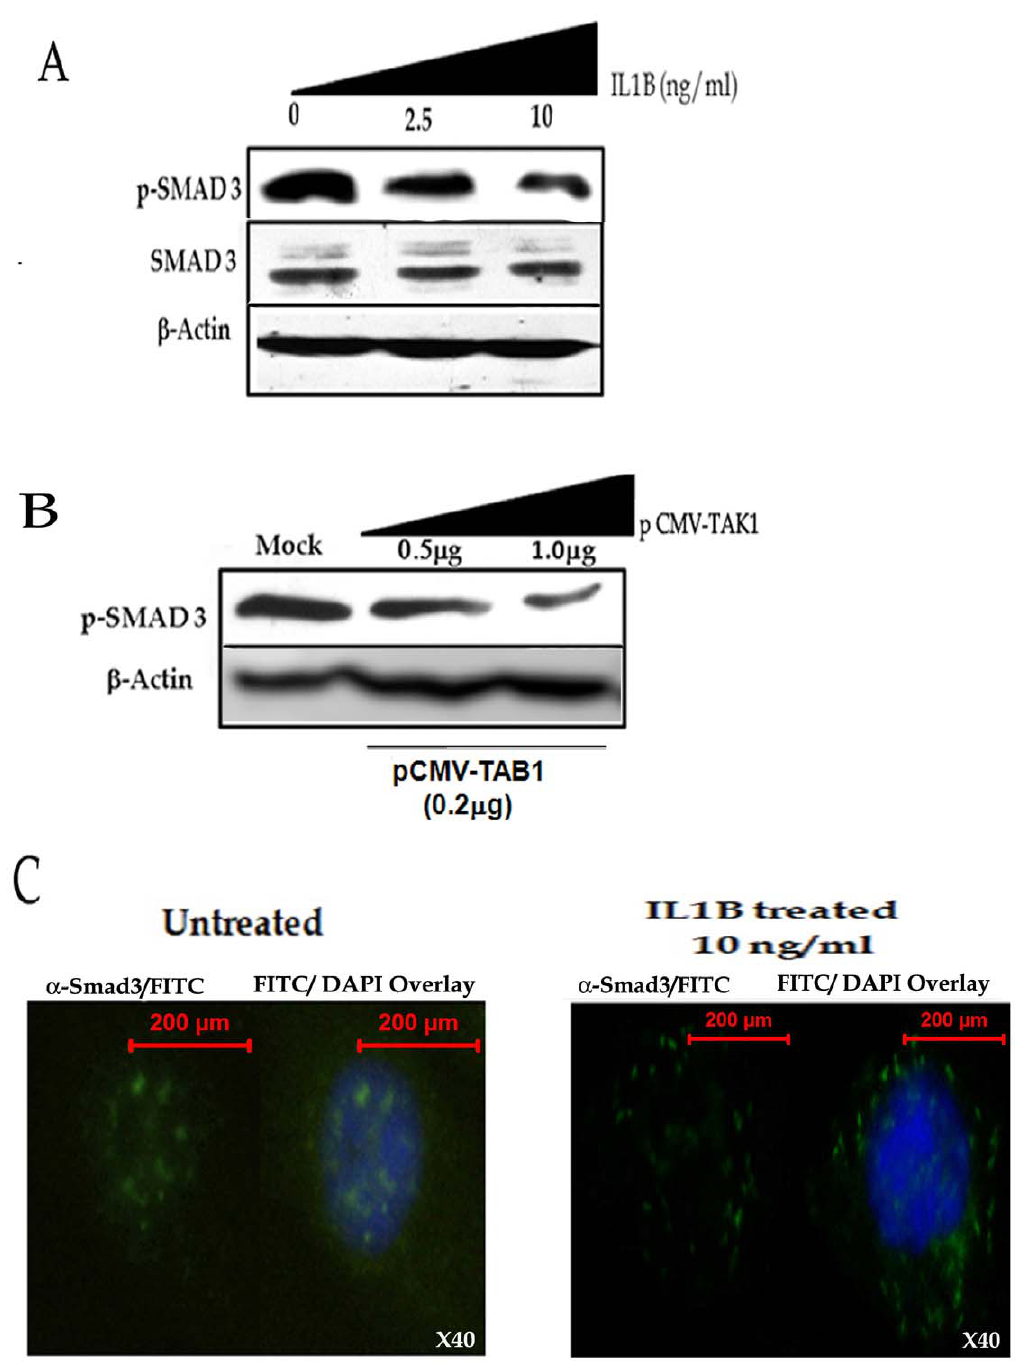
Figure 3. IL1B inhibits Smad 3 phosphorylation thus perturbing its nuclear localization. AGS cells were treated with increasing concentration of recombinant IL1B protein for two hours and then lysed and immuno-blotted with (A) phosphorylated Smad3 specific antibody (p- SMAD 3) and antibody against Smad 3 protein (SMAD 3). A representative blot is shown. (B) AGS cells were co-transfected with different concentrations pCMV-TAK1 and equal amount of pCMV-TAB1, the two immediate downstream mediator of IL1B, and harvested for immuno-blot analysis with p-SMAD3 antibody after forty eight hours. A representative blot is shown. (C) Nuclear localization of Smad 3 in AGS cells treated with or without IL1B (10 ng/ml). In each panel the left section represents FITC conjugated anti-SMAD 3 antibody and the right panel represents the overlay of DAPI/FITC images captured at that field. The experiment establishes that IL1B inhibits nuclear translocation of Smad 3.